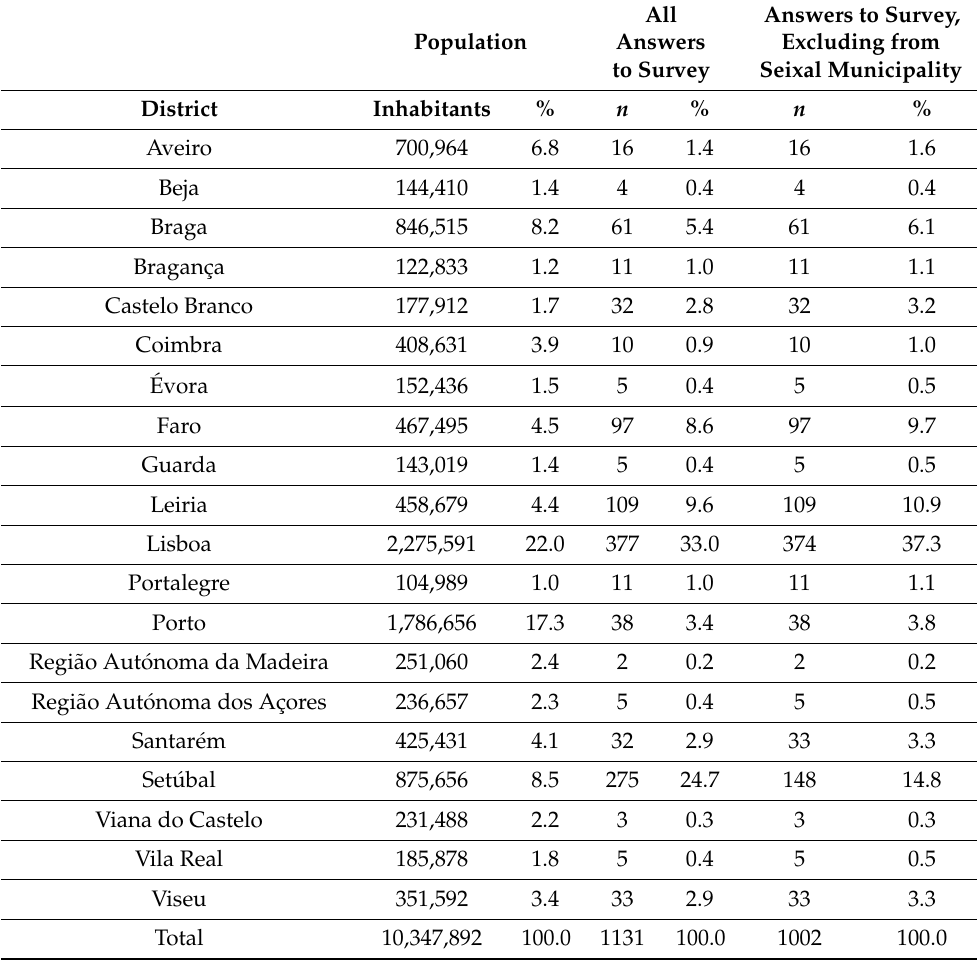
Table 1. Portuguese population per district and answer rate to the survey per Portuguese district, considering all the answers received and excluding the ones from UFSAAPP parish ( n = 129).